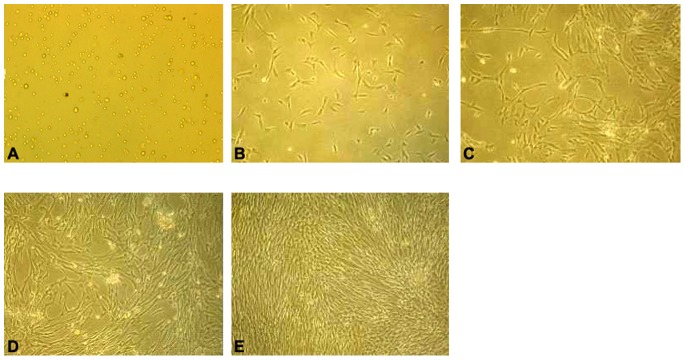
Inoculation, Culture and passage of Rabbit BMMSCs.(A) Primary BMSCs were inoculated, presented with round shape (magnification ×100). (B) There were a large number of adherent cells. Cell division could be seen at this phase (magnification ×100). (C) Within 4 to 5 days, the cells entered into logarithmic growth phase in which the amount increased and the cells arranged closely more like fibroid cells morphology (magnification ×100). (D) Within 8 to 10 days cell monolayer fused closely to 80% with swirl-like growth (magnification ×100). (E) The cells in the third generation were of the uniform morphology which grew with parallel or spiral arranging, and they became monolayer fused in 6 to 7 days (magnification ×100).